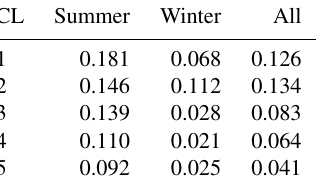
Table 4. EMD values for each cluster between Airbase and MACC data (2007–2010); first CA. CL Summer